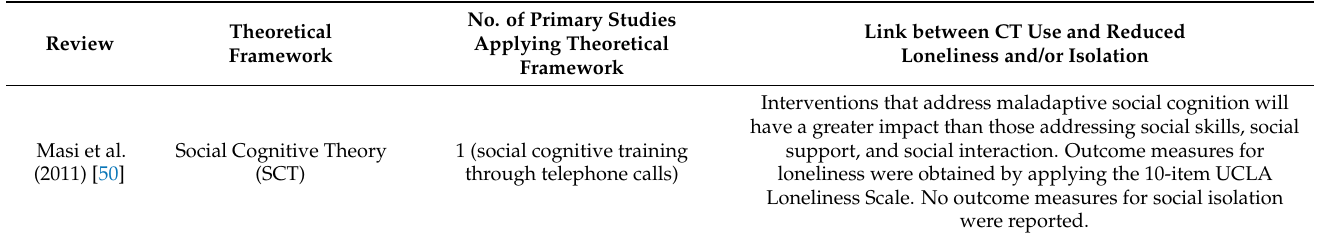
Table 3. Theoretical Frameworks Linking CT Use with Reduced Loneliness and Social Isolation Among Older Adults as Represented in the Included Research Reviews.